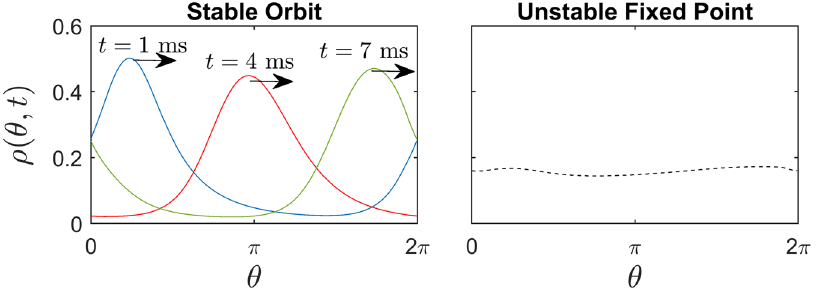
Figure 1. The left panel shows a stable periodic orbit of (8) which represents its unperturbed infinite time behavior. For this solution, the probability distribution travels from left to right in a highly synchronized manner. The right panel shows an unstable fixed point for the same model with a nearly uniform (desynchronized) distribution.